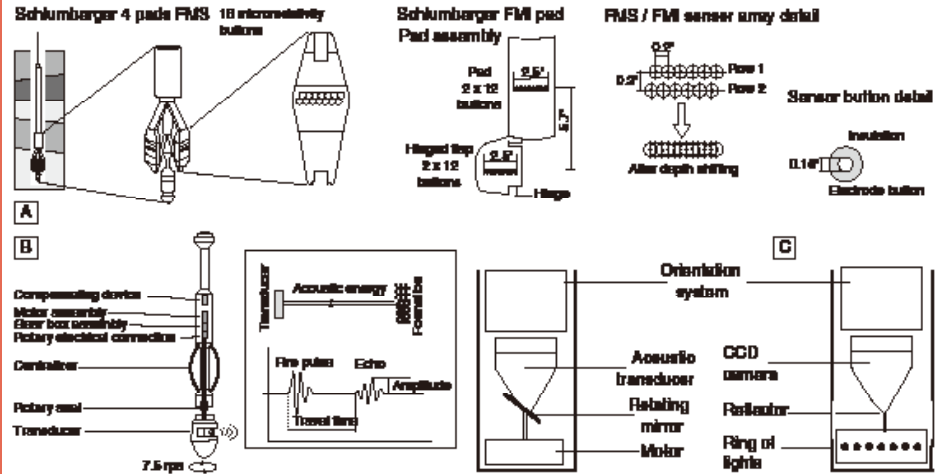
Figure 1. Sketch of electrical, acoustic and optical imaging tools. [A] Schlumberger Formation MicroScanner (FMS) with four pads, 16 buttons per pad, covering 25%–40% of hole diameter, and Schlumberger Fullbore Formation MicroImager (FMI) with 4 pads, 4 hinged flaps, and 24 buttons on each pad and flap. The hinged flap is able to increase coverage by up to 80% (modified from Ekstrom et al., 1987). The buttons are aligned in two rows; processes for depth corrections shift the recorded resistivity to one row. Each button consists of an electrode surrounded by insulation. [B] The Ultrasonic Borehole Imager features a high resolution transducer that provides acoustic images of the borehole wall. The transducer emits ultrasonic pulses at a frequency of 250 kHz or 500 kHz (low and high resolution, respectively), which are reflected by the borehole wall and then received by the same transducer. Amplitude and travel time of the reflected signal are then determined. [C] Optical televiewers generate a continuous oriented 360° image of the borehole wall unwrapped using an optical imaging system (downhole CCD camera which views a reflection of the borehole wall in a conic mirror- sketch of advanced logic technology ALT OBI40). Like electrical imaging tools and acoustic televiewers, the optical televiewers include a full orientation device consisting of a precision 3-axis magnetometer and 2 accelerometers, thus allowing for accurate borehole deviation data to be obtained during the same logging run and for accurate and precise orientation of the